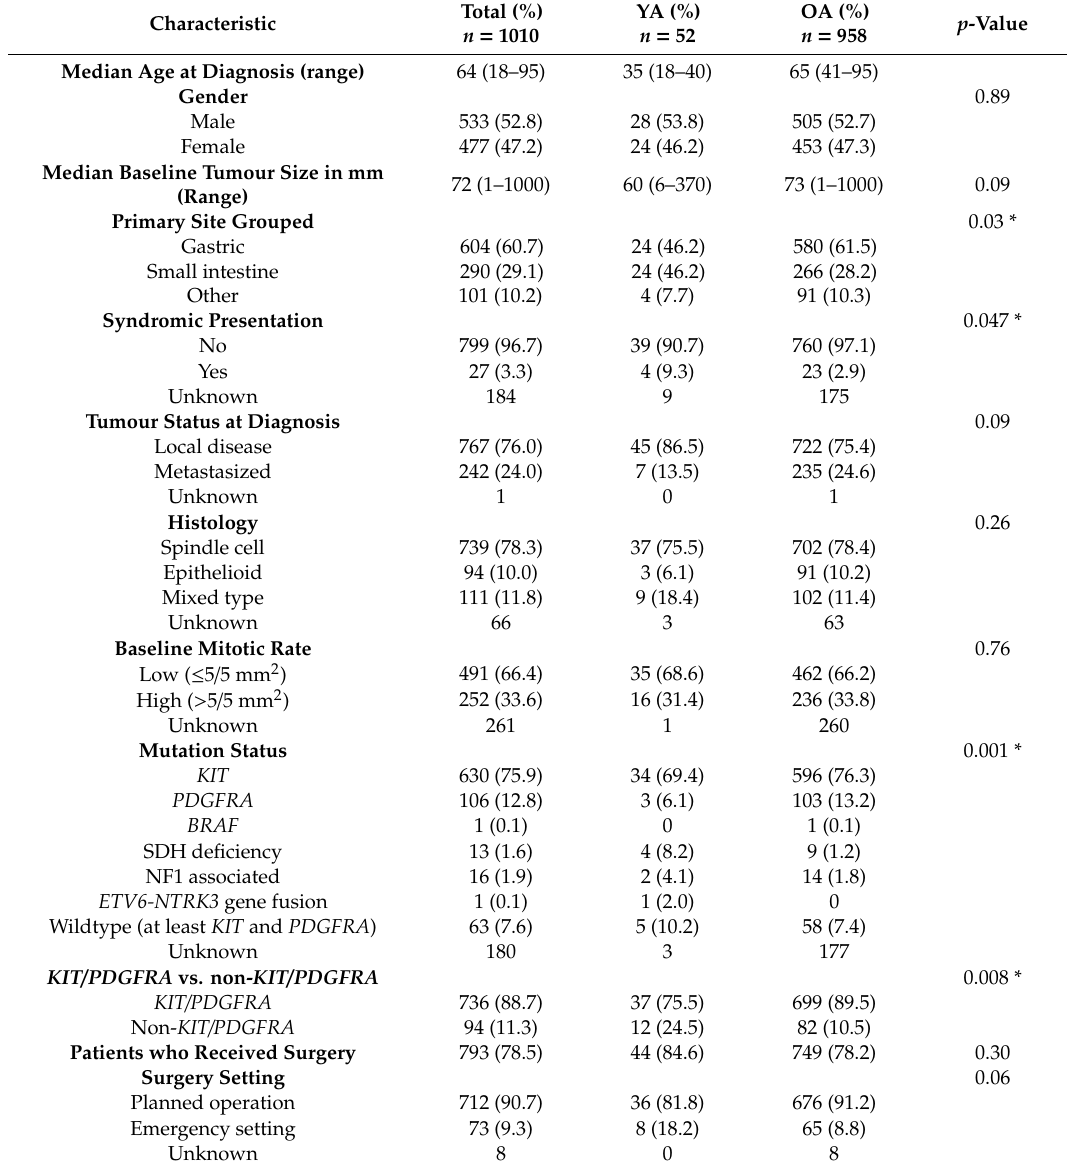
Table 4. Clinical and tumour characteristics in the young adult (YA) and older adult (OA) age